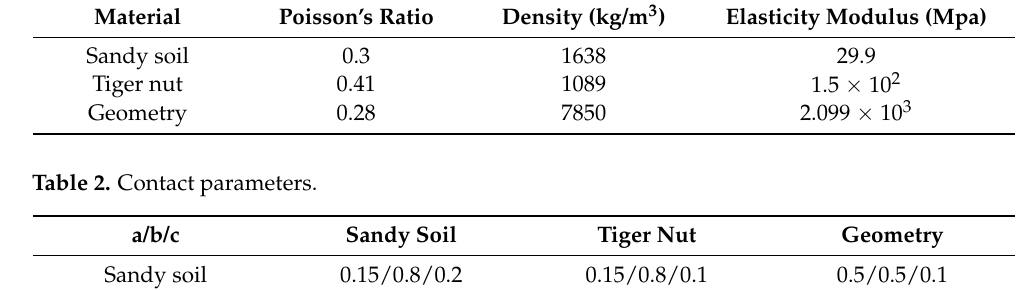
Table 1. Intrinsic parameters.